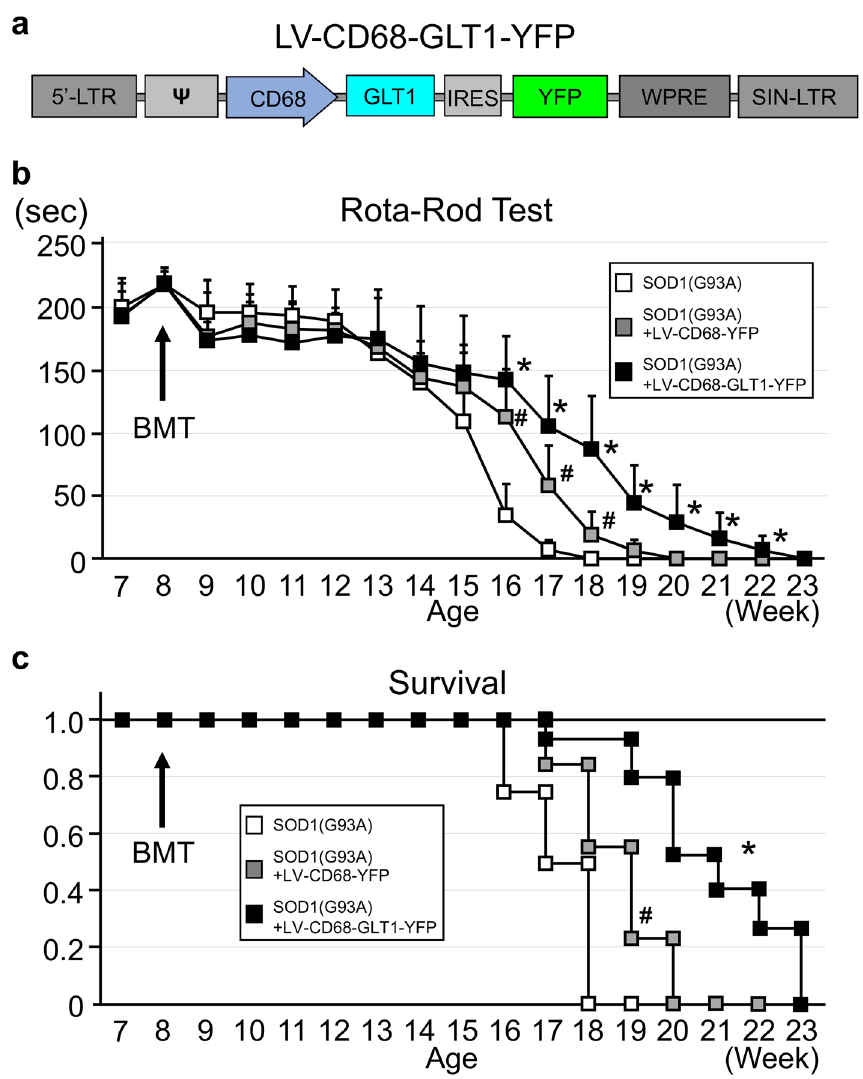
Figure 5. Effect of GLT1 gene delivery with bone marrow transplantation on motor functions and survival of SOD1(G93A) mice. ( a ) Schematic representation of LV-CD68-GLT1-YFP. ( b ) Motor functions were evaluated by the rotarod test once a week in SOD1(G93A) mice (n = 12), SOD1(G93A) mice with [SOD1(G93A) + LV-CD68-GLT1-YFP, n = 15] or without GLT1 gene expression vector treatment [SOD1(G93A) + LV-CD68-YFP, n = 13]. Error bars represent the mean + S.D. *p < 0.05 between SOD1(G93A) + LV-CD68-GLT1-YFP and other two groups, and #p < 0.05 between SOD1(G93A) and SOD1(G93A) + LV-CD68-YFP groups at each time point. ( c ) Kaplan–Meier survival curves in accordance with the survival rate at each week for SOD1(G93A) mice (n = 12), SOD1(G93A) mice with [SOD1(G93A) + LV-CD68-GLT1-YFP, n = 15] or without GLT1 gene expression vector treatment [SOD1(G93A) + LV-CD68-YFP, n = 13]. Y-axis shows the survival rate. *p < 0.05 between SOD1(G93A) + LV-CD68-YFP and SOD1(G93A) + LV-CD68-GLT1-YFP groups and #p < 0.05 between SOD1(G93A) and SOD1(G93A) + LV-CD68-YFP groups with the log-rank test. IRES internal ribosome entry